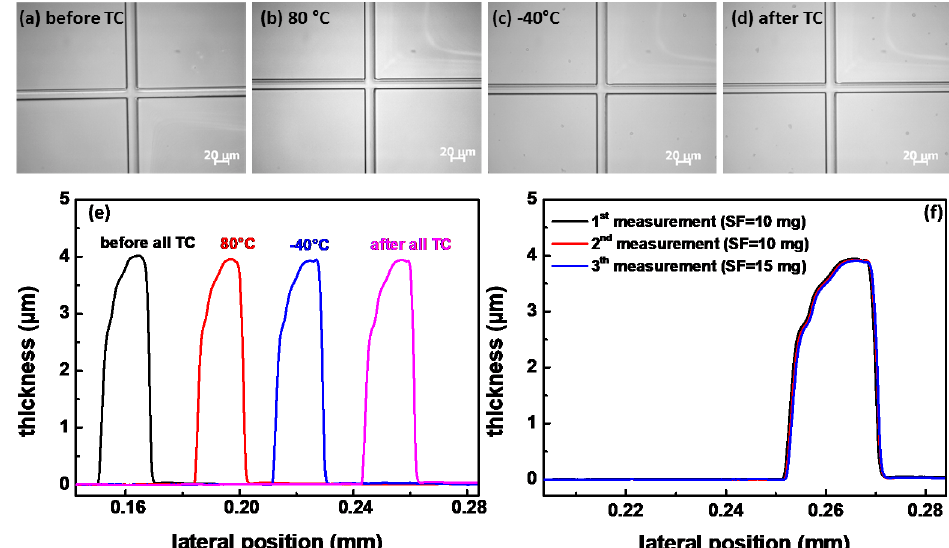
Figure 19. Thermal cycling (TC) effect on a TiO 2 –SiO 2 grid architecture. Microscope images of the grid area are given ( a ) before the thermal cycling, ( b ) after being thermally treated at 80 °C, ( c ) − 40 °C and ( d ) after all the consecutive thermal treatments. ( e ) Corresponding profilometer measurements (SF = 10 mg) and ( f ) profilometer measurements of the structure submitted to the full thermal cycling with SF of 10 mg (black and red lines) and 15 mg (blue line).